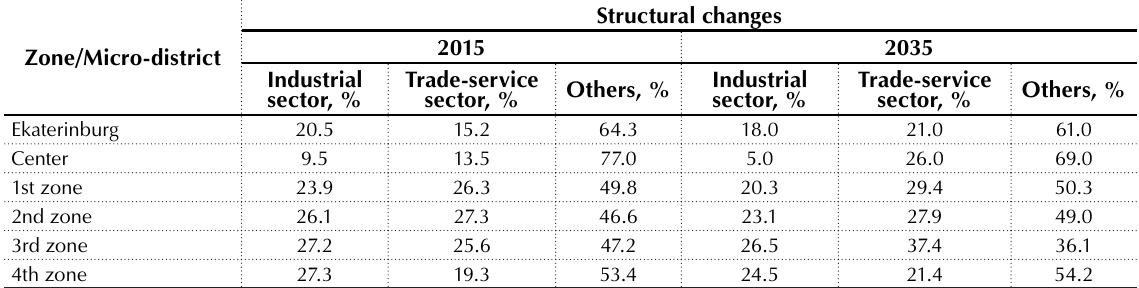
0%5%10%15%20%25%30%35%40%45% Figure 3. The structure of population in the context of spatial zones, 2015 and 2035 Table 1. Forecast of the structure of employed in terms of the key sectors of the Ekaterinburg